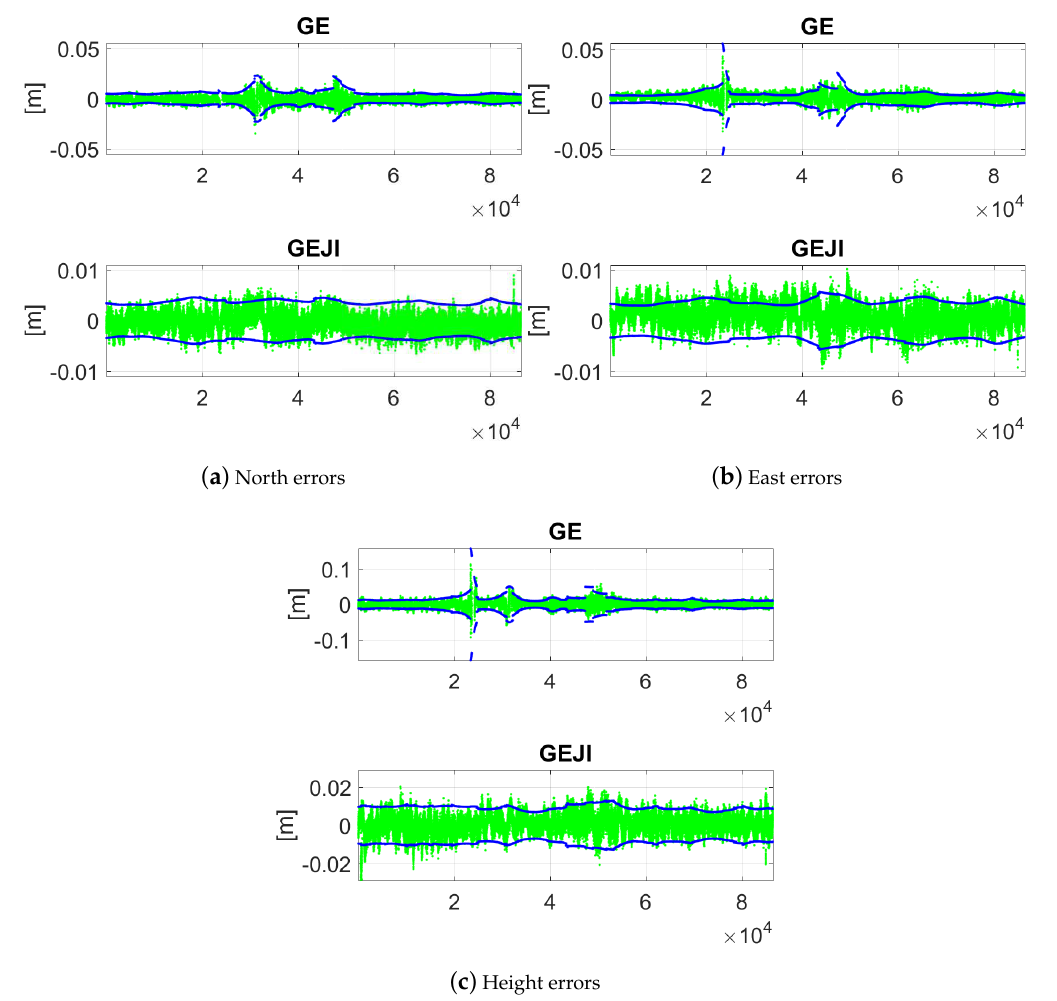
Figure 12. Ambiguity-fixed baseline errors in the north ( a ); east ( b ); and height ( c ) directions with the elevation mask of 10 degrees. Data for baseline CUAA-CUCC on DOY 224, 2018 was used. The green and blue dots are the ambiguity-correctly-fixed solutions and their 95% formal confidence intervals, respectively. Note that the scales of the sub-figures are